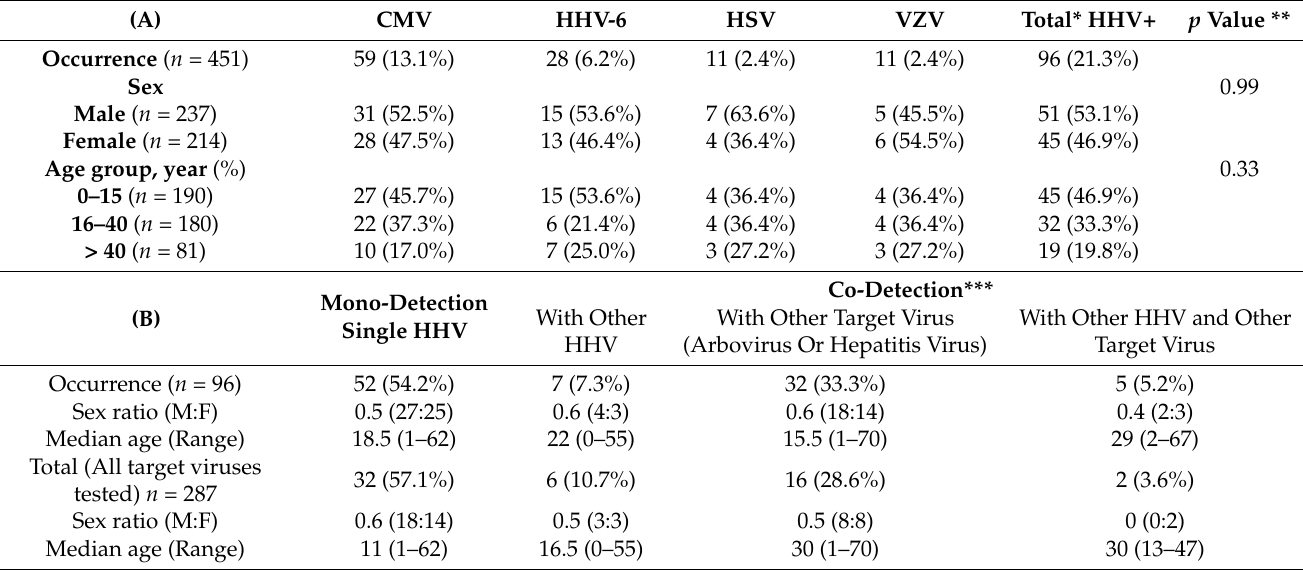
Table 1. ( A ) Occurrence and demographic characteristics of HHVs detected in patients suspected of yellow fever in the DRC. ( B ) Occurrence and demographic characteristics of mono- and co-detection of HHV and other target